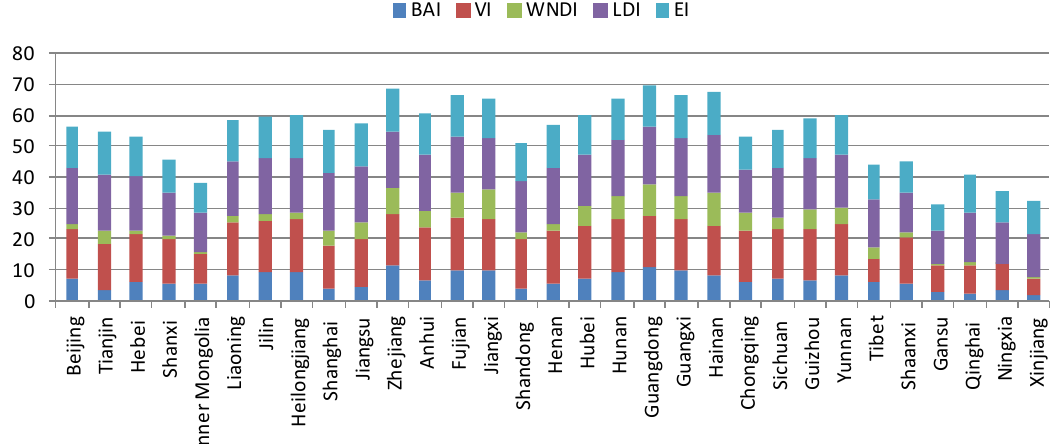
Figure 3. EQI distribution in each